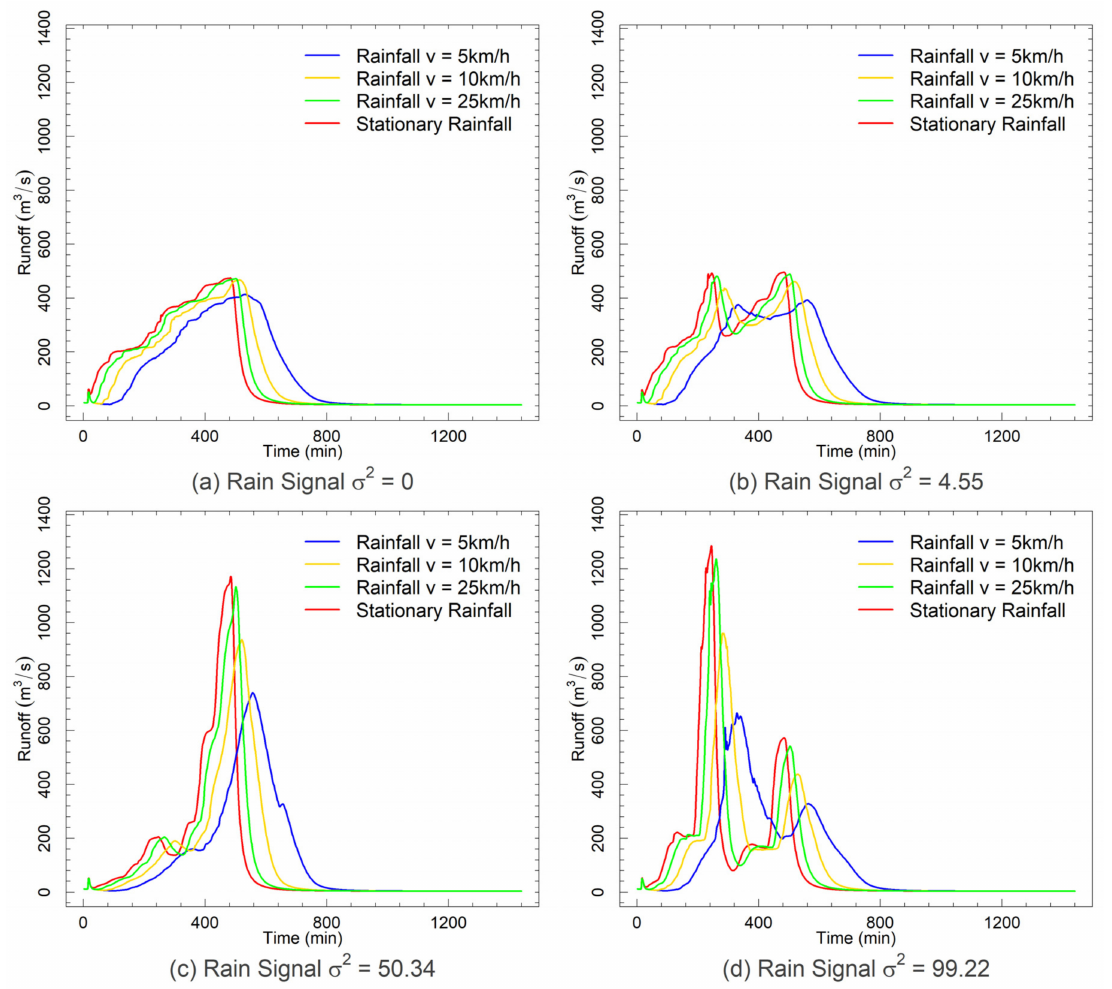
Figure 6. Hydrographs (at measuring point A) for four generated rains (Figure 3a,b,e,f) under stationary and moving setups with velocities v = 5 km/h, v = 10 km/h, v = 25 km/h with a direction from west to